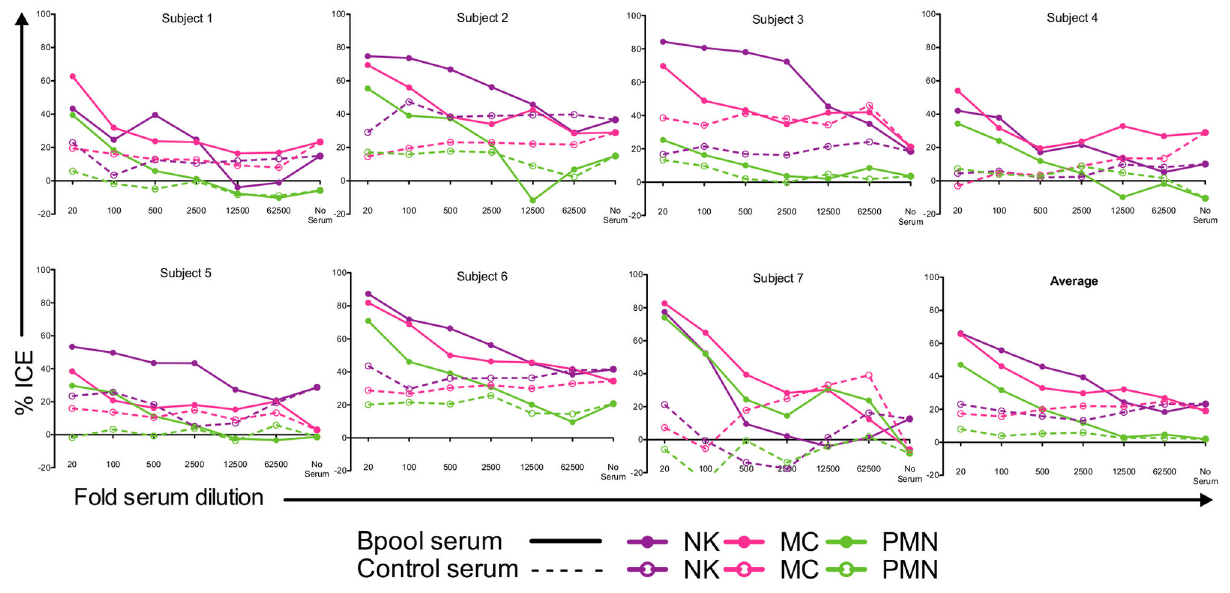
Figure 3. NKs, MCs, and PMNs mediate ICE. Percentage ICE mediated by NKs, MCs, and PMNs in seven subjects, at an effector:target ratio of 10:1 without or with Bpool (HIV + ) or control (HIV - ) serum at serial 5-fold dilutions starting at 1:20. Each datum point represents the mean of duplicate